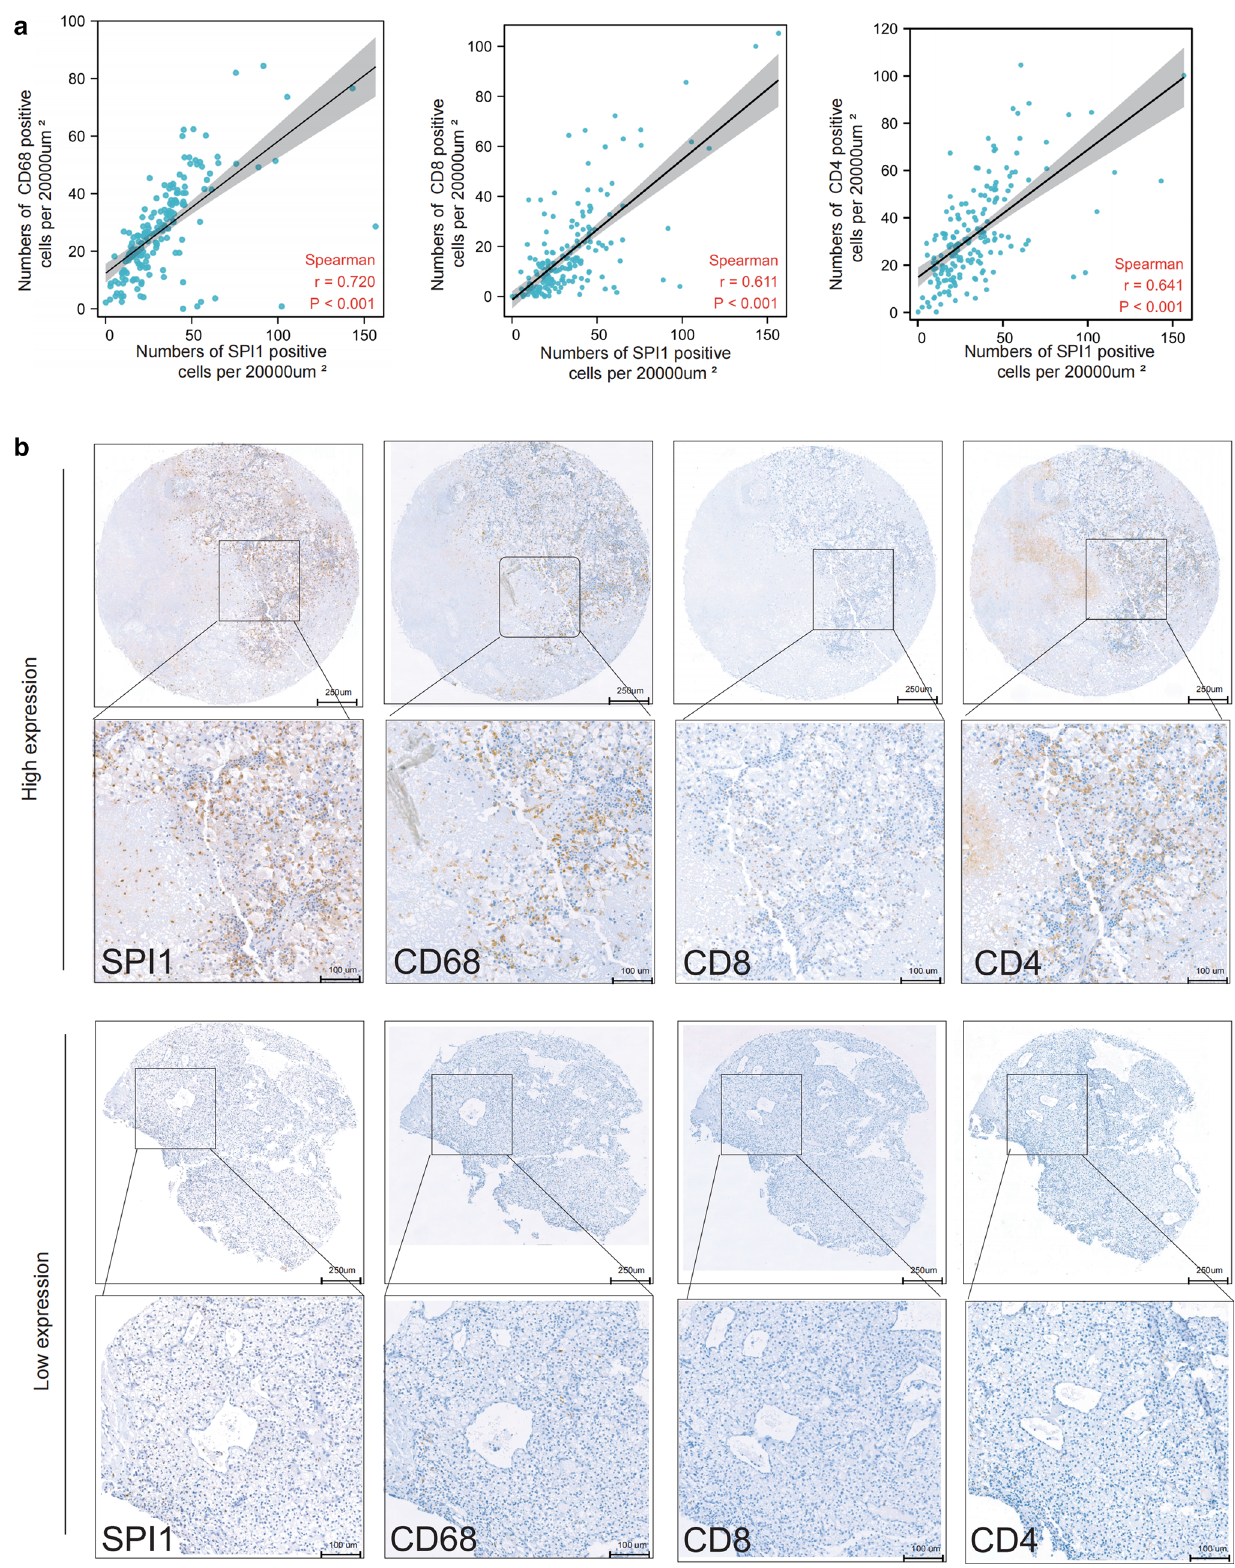
Fig. 4 Relationship between SPI1 expression and CD68 + macrophages, CD4 + T cells, and CD8 + T cells infiltration. a SPI1 expression correlated posi- tively with CD68 + macrophages, CD4 + T cells, and CD8 + T cells infiltration in our cohort. b SPI1 , CD68 + , CD8 + , and CD4 + expression levels in the same patients are shown by IHC. ccRCC, clear cell renal cell carcinoma; *, p < 0.05; **, p < 0.01; ***, p < 0.001; IHC,